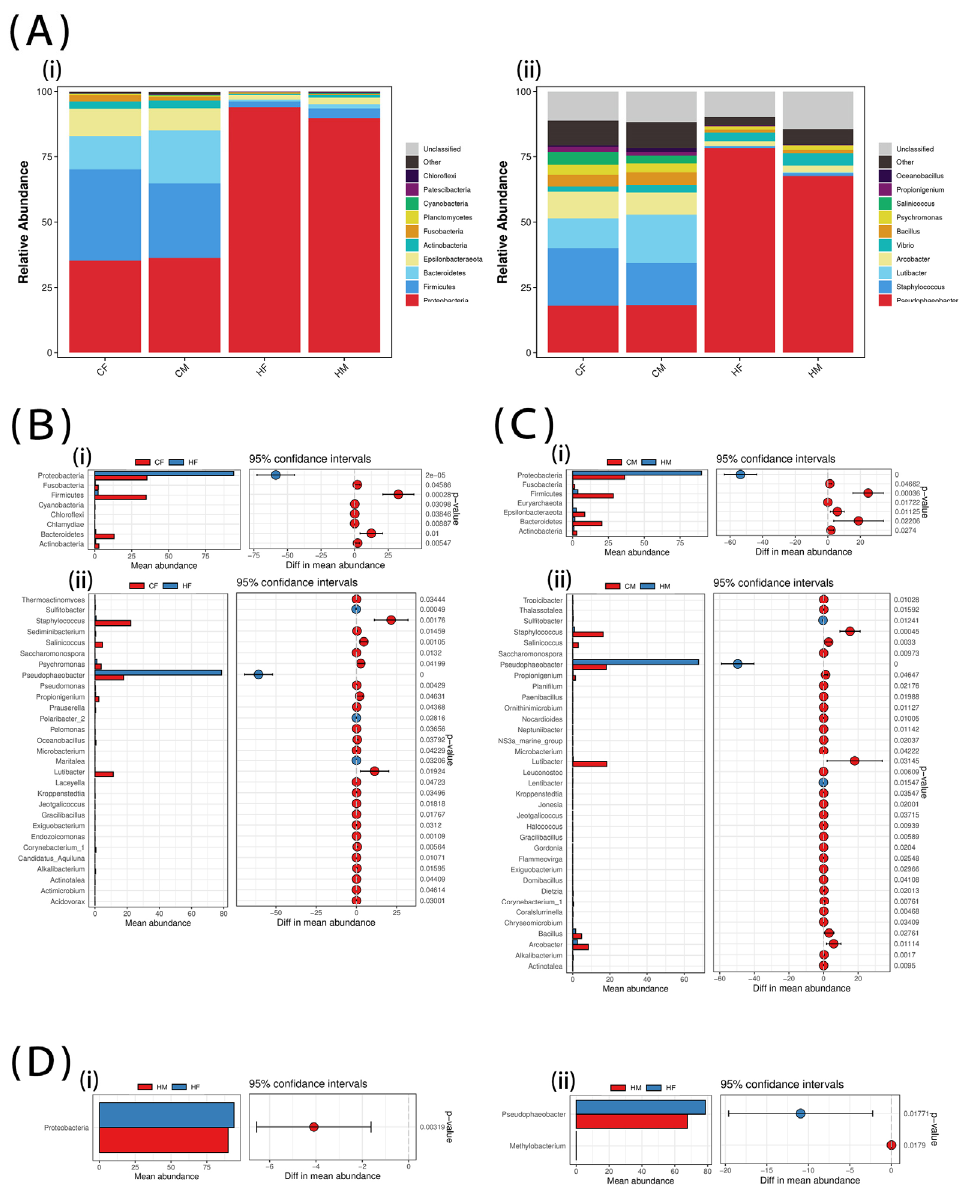
Figure 1. Species composition analysis of intestinal microbiota in sea cucumbers [(i): phyla; (ii): genus]. ( A ) The top ten most-abundant microbiota in each experimental group; ( B ) Microbiota that were significantly different between CF and HF. ( C ) Microbiota that were significantly different between CM and HM. ( D ) Microbiota that were significantly different between HM and HF.